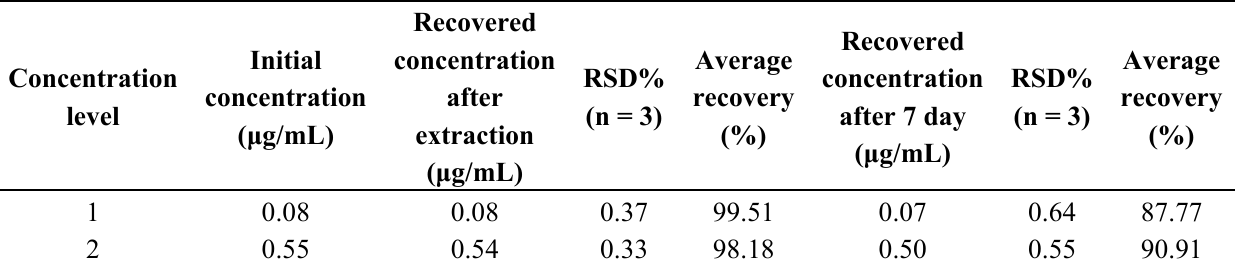
Table 3. Stability studies of standards shikonin under optimum homogenate extraction conditions.